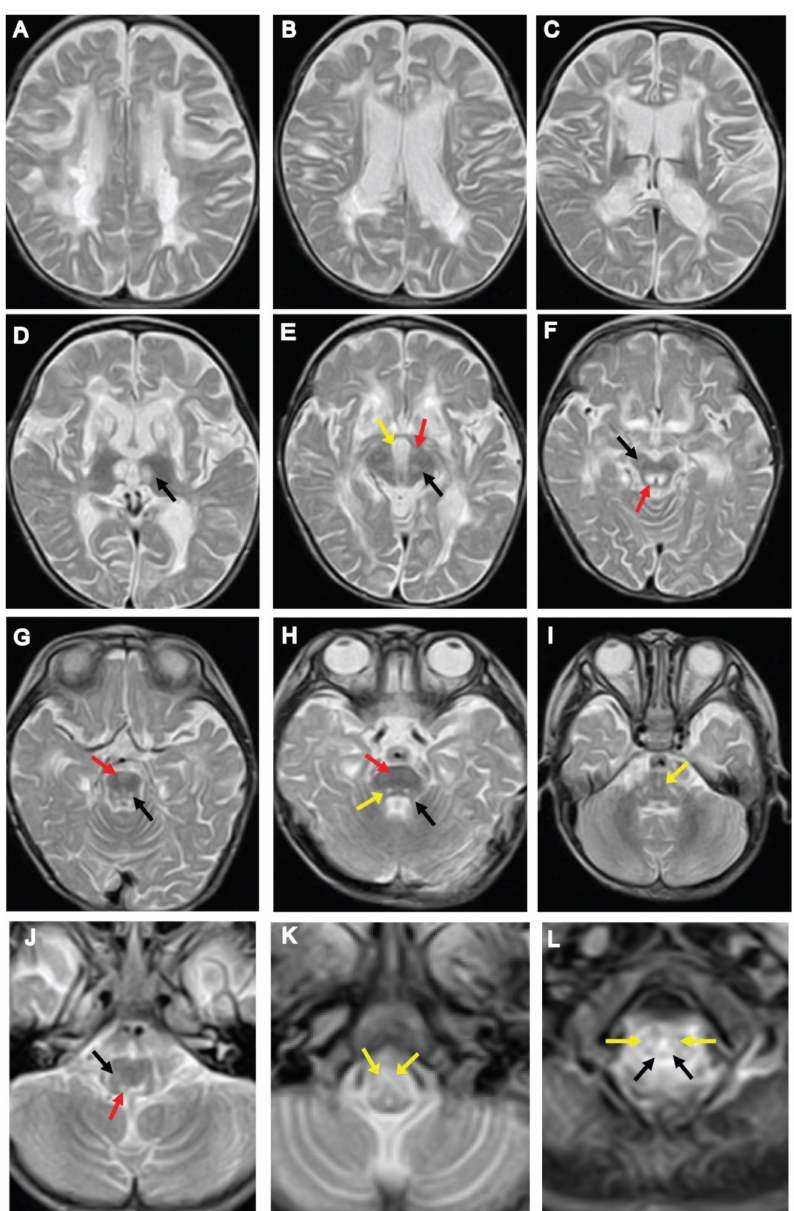
Figure 1. Neuroimaging findings at three years of age. ( A – C ) Axial T2-weighted images of brain MRI showing signal abnormalities in the periventricular white matter, putamen, caudate nucleus, splenium of the corpus callosum, and anterior and posterior limb of the internal capsule. ( D ) Symmetrical bilateral areas of increased signal intensity in the medial thalamic nucleus (black arrow). ( E , F ) Axial T2-weighted images of the midbrain: ( E ) interpeduncular cistern (yellow arrow), cerebral peduncle (red arrow), substantia nigra (black arrow); ( F ) substantia nigra (black arrow) and periaqueductal region (red arrow). ( G – I ) T2-weighted images of the pons: ( G ) pyramidal tract (red arrow), pontine tegmentum (black arrow); ( H ) superior cerebellar peduncle (black arrow), pyramidal tract (red arrow), pontine tegmentum (yellow arrow); ( I ) di ff use hyper-intensive lesions in the medial lemniscus (yellow arrow). ( J , K ) T2-weighted images of the medulla oblongata shows abnormal intensities in the medullary tegmentum, spinocerebellar tracts, and pyramids: ( J ) medullary tegmentum (red arrow), spinocerebellar tract (black arrow); ( K ) pyramids (yellow arrow). ( L ) T2-weighted images of the upper cervical spinal cord revealed abnormal intensity within the lateral corticospinal tracts (yellow arrows) and the dorsal columns (black